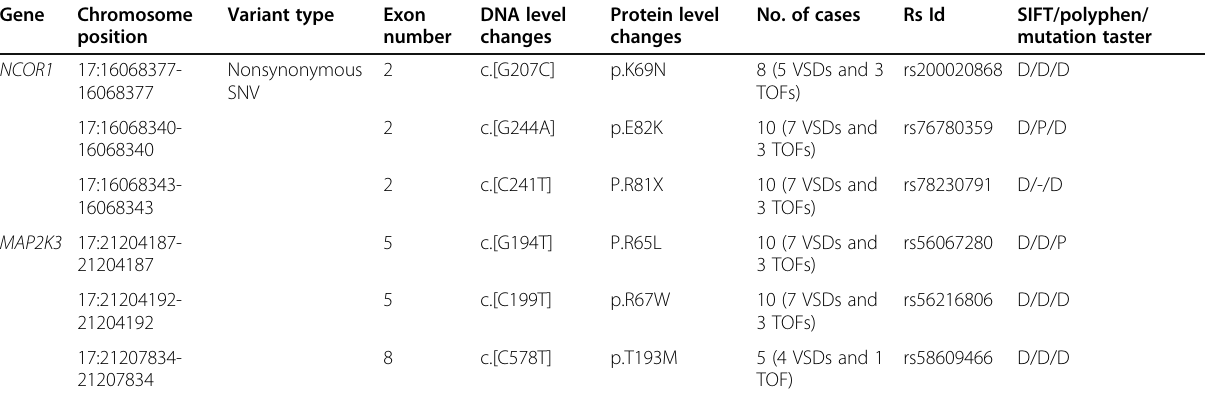
Table 2 Overlapping NCOR1 and MAP2K3 variants across 10 subjects with VSD and TOF positioned on chromosome 17 Gene Chromosome Variant type Exon DNA level Protein level No. of cases Rs Id SIFT/polyphen/ position number changes changes